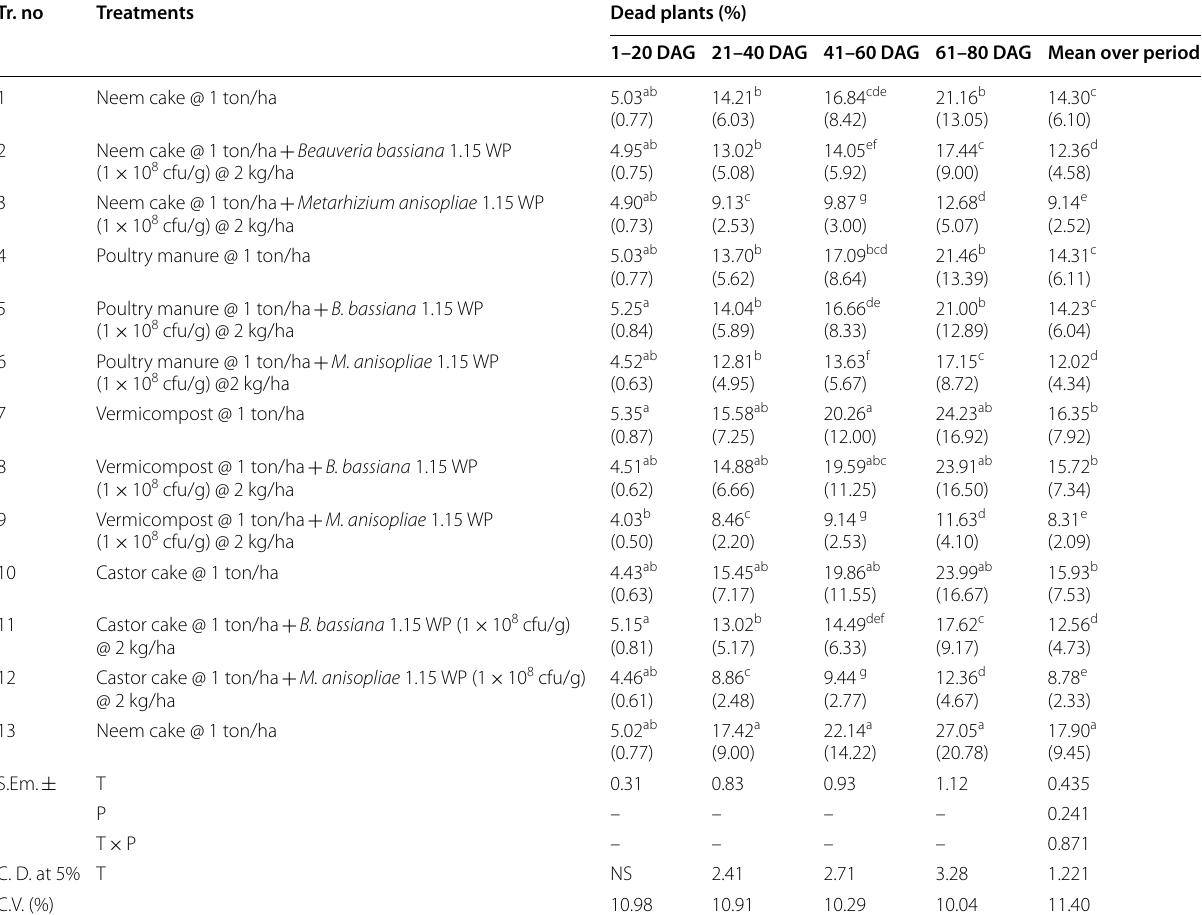
Table 3 Effect of entomopathogenic fungi enriched with organic amendments against white grub in groundnut (season of 2019) Tr.